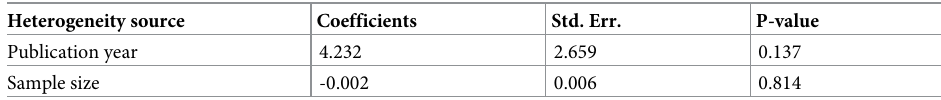
Table 2. Meta-regression analysis of factors affecting between-study